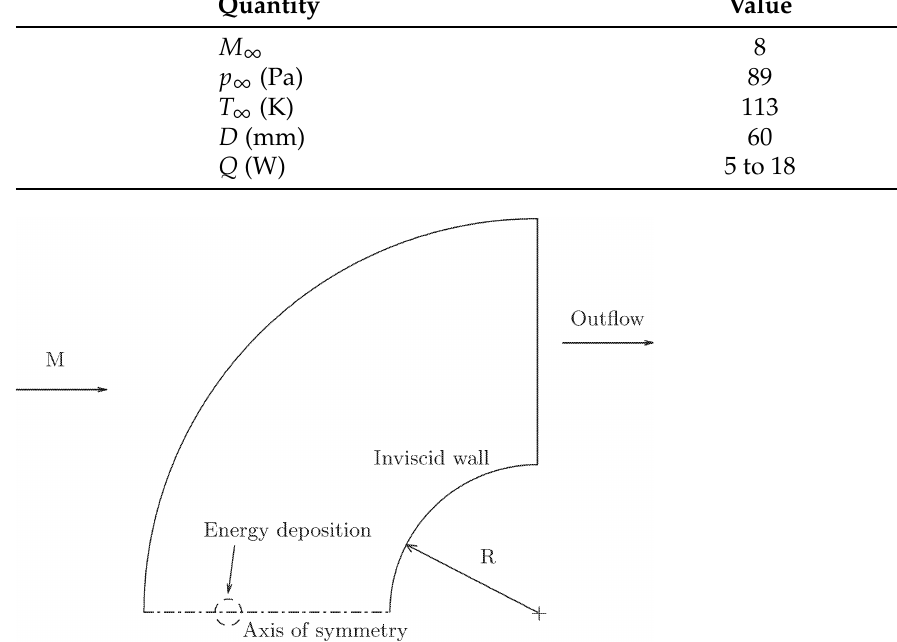
Table 12. Flow Conditions.